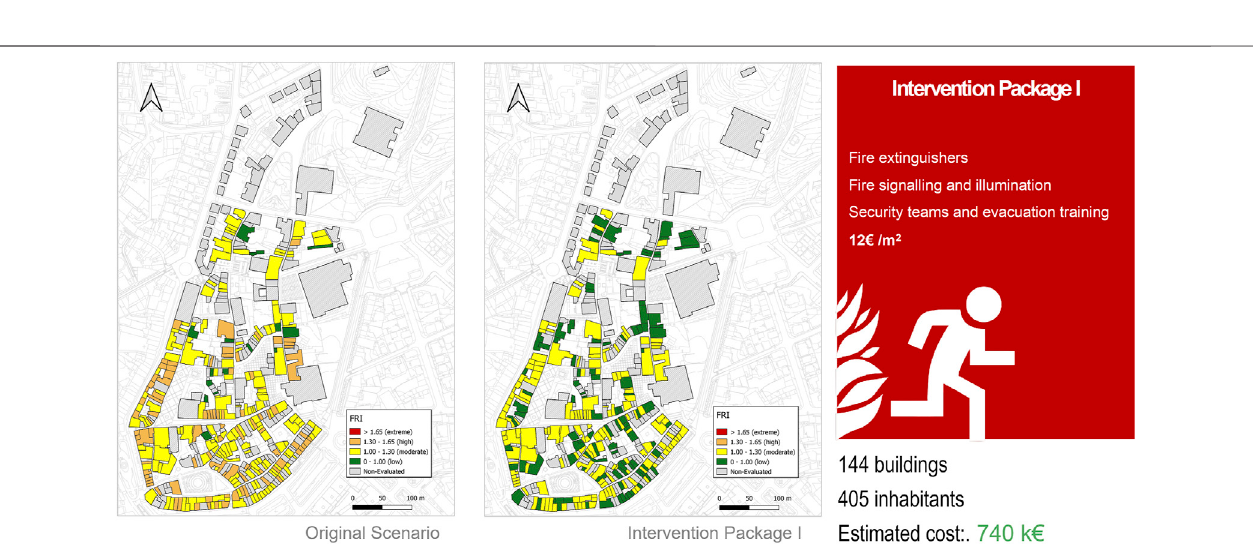
FIGURE 8 | Cost-bene fi t analysis of implementing an intervention package for the city of Guimarães. Adapted from Tozo Neto and Ferreira (2020).